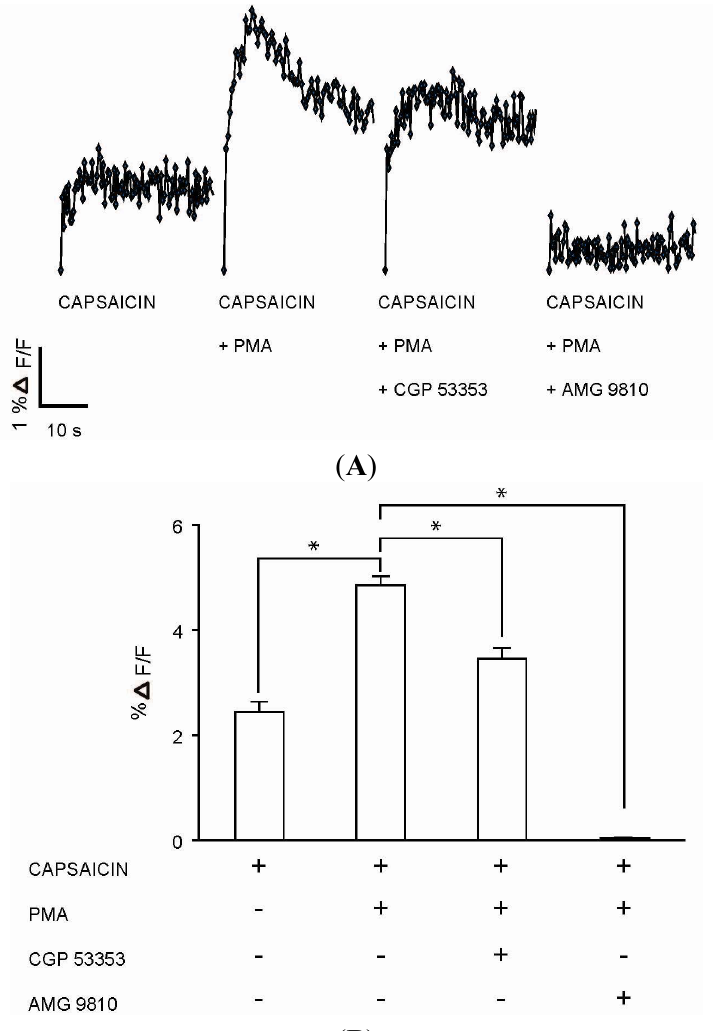
Figure 5. PKC β II sensitizes TRPV1-mediated calcium signaling in DRG